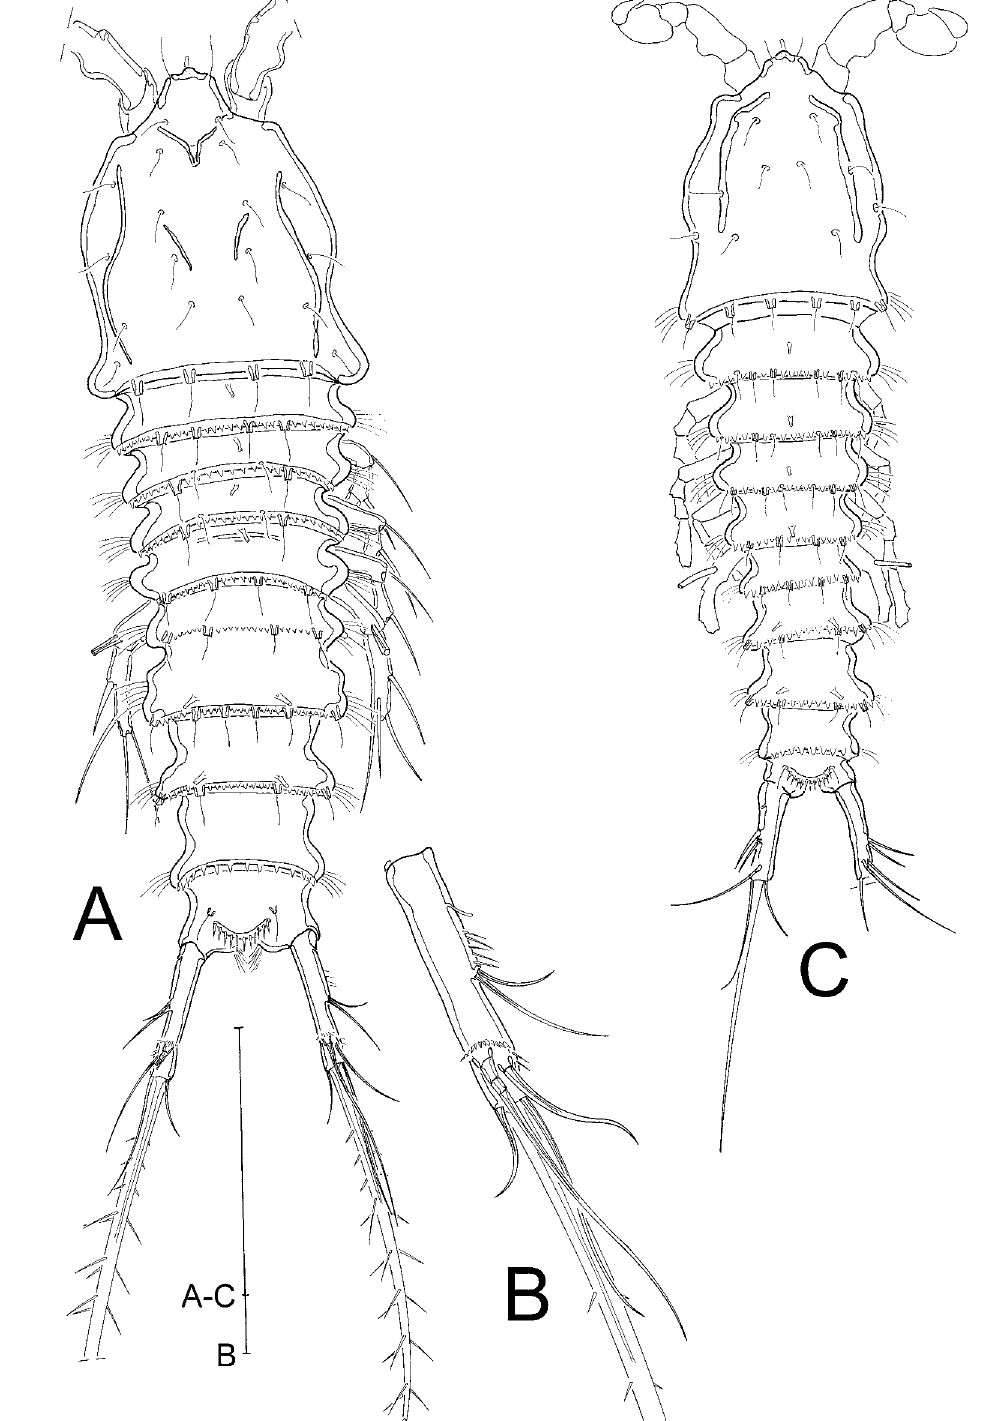
Fig. 12. Laophontodes gertraudae sp. nov., paratypes. A–B . ♀ (SMF 37117/1). A . Habitus, dorsal view. B . right furcal ramus, dorsal view. C . ♂ (SMF 37118/1). Habitus, dorsal view. Scale bar: A, C = 100 µm, B = 50